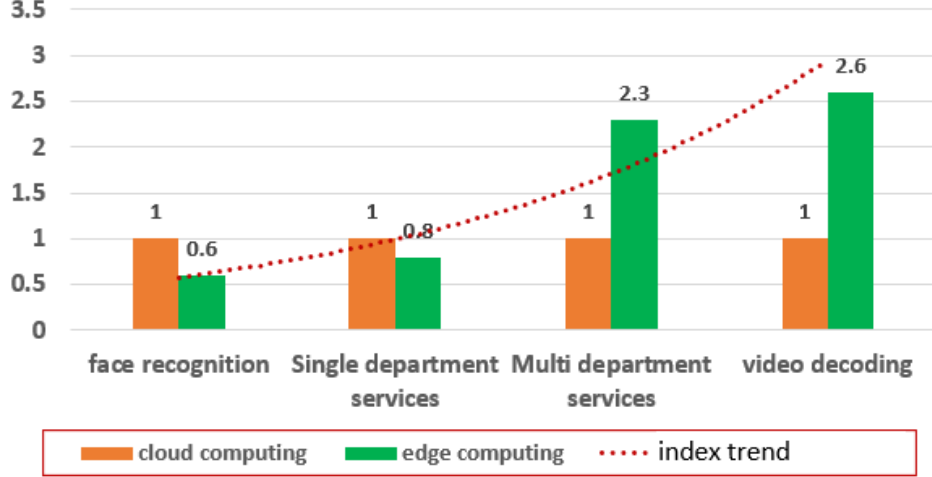
Figure 5. Task processing efficiency